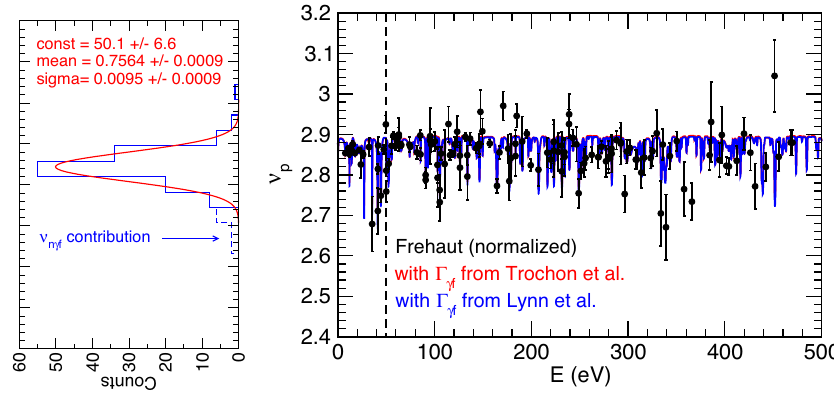
Figure 6. Comparison between the ν p results obtained up to 500 eV using Γ γ f from Trochon et al. and Lynn et al., and the normalized data from Fréhaut (right panel). The ν p histogram of the data from Fréhaut has been fitted to a gaussian distribution (left panel), showing a dispersion of the